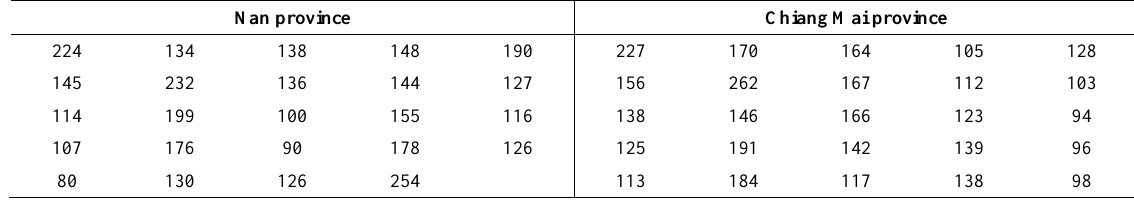
Table 4. PM10 data of the Nan and Chiang Mai province s (µg/m 3 ).